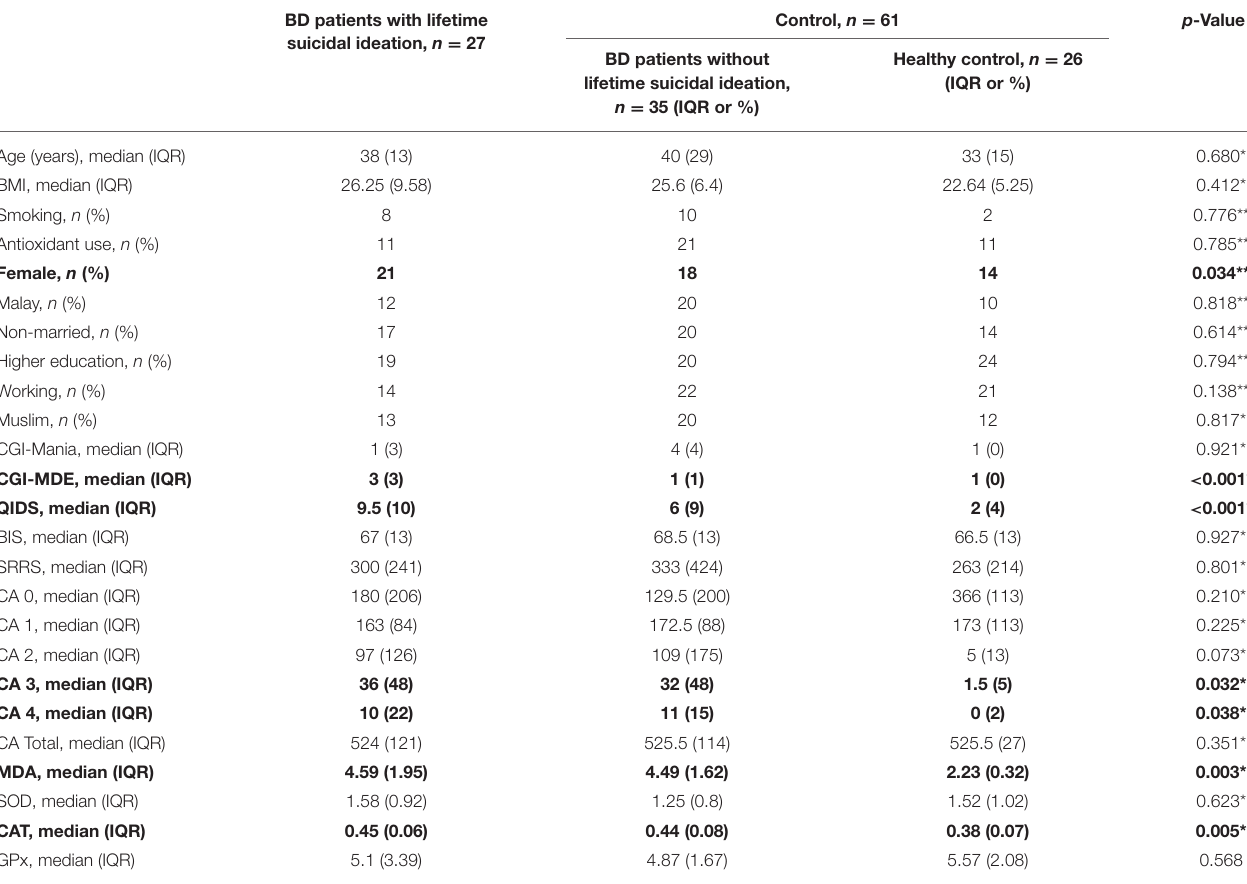
TABLE 2 | Differences in demographics, clinical characteristics, and oxidative stress between case (BD patients with lifetime suicidal ideation) and control (BD patients without lifetime suicidal ideation and healthy control) ( n = 88). BD patients with lifetime suicidal ideation, n =